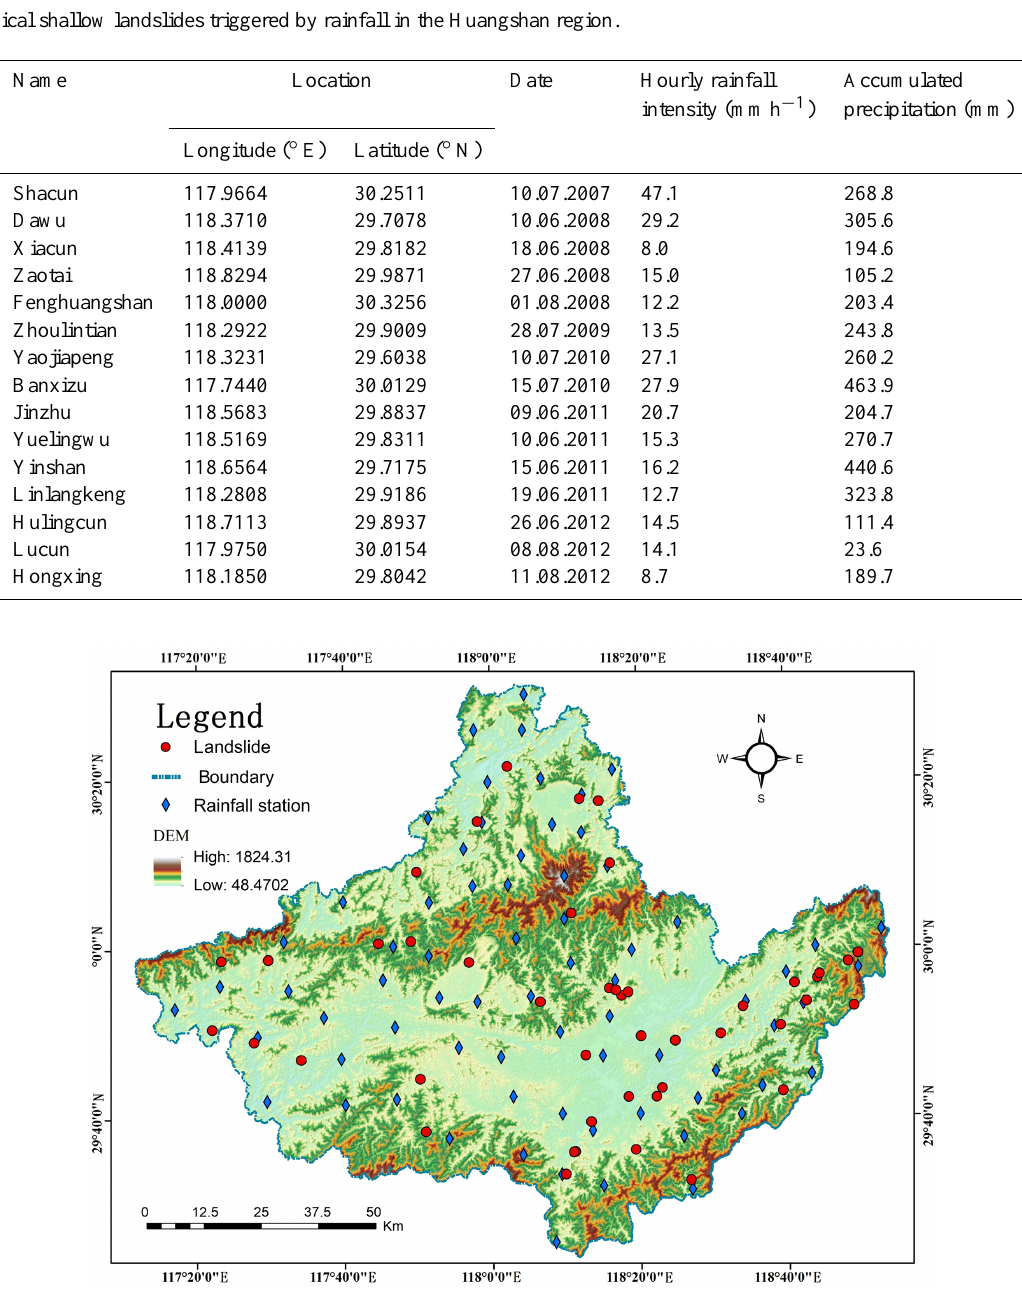
Figure 3. Location of rainfall-induced shallow landslides in the Huangshan region